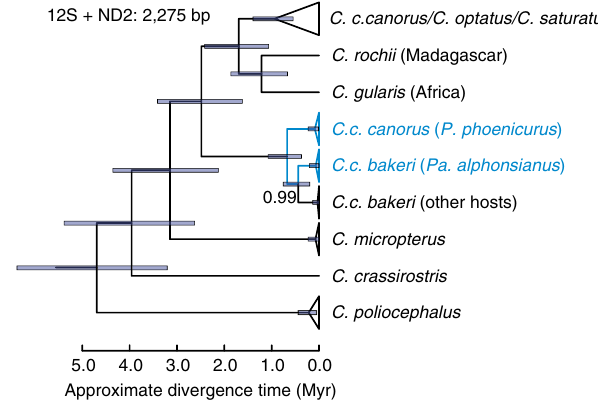
Figure 4 | Phylogenetic relationships and dating. Mitochondrial